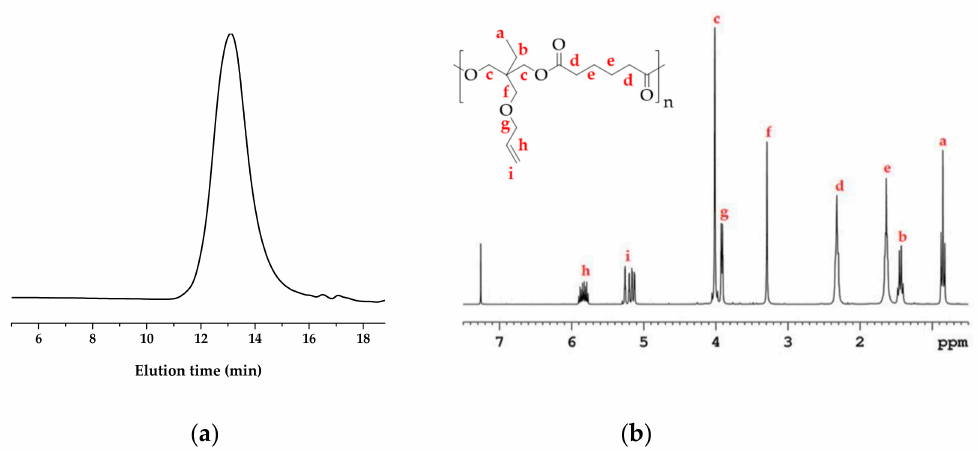
Figure 1. SEC curve ( a ) and 1 H NMR spectrum ( b ) of the P(TPAE- alt -AD) polyester, where the peaks labeled (a–i) correspond to the protons of the polyester shown